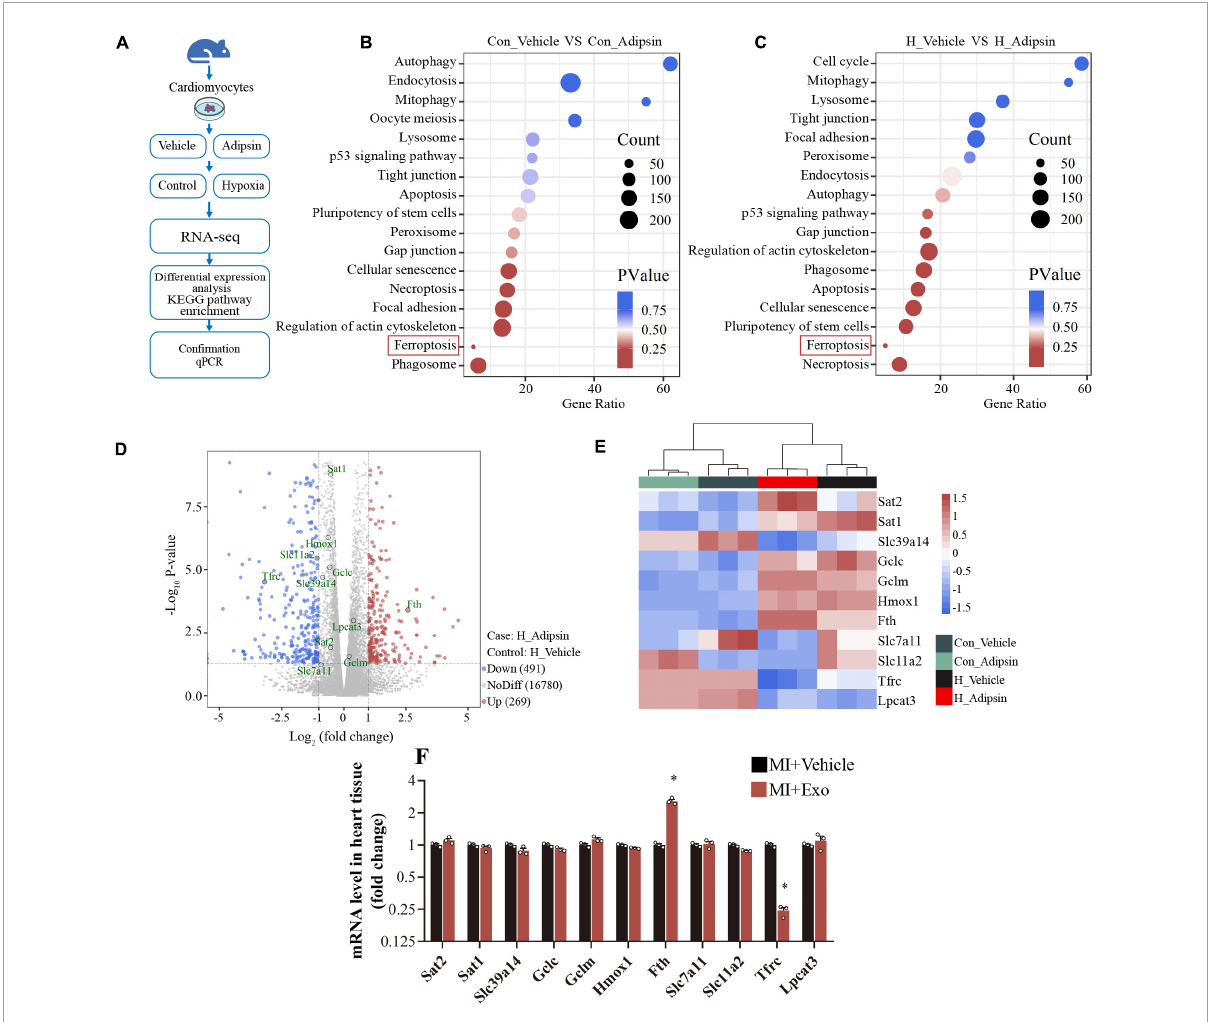
FIGURE4 Adipsin regulates ferroptosis pathway in vitro . (A) Flowchart of the study design. Neonatal mouse ventricular cardiomyocytes were treated with recombinant Adipsin protein. Following that, cardiomyocytes were exposed to hypoxia for 6–8 h. Next, RNA sequencing was performed on the cell genome. (B,C) Pathway enrichment investigation. (D) Under hypoxia, the Volcano graph shows differentially expressed genes. (E) The Heatmap of differentially expressed genes about ferroptosis. (F) Using quantitative PCR, the expression profile of ferroptosis-related genes in cardiac tissue post MI was investigated after Adipsin-enriched pericardial-AT exosomes treatment. n = 3, * p < 0.05 vs. MI + Vehicle group. Data were mean ± SEM, and one-way ANOVA was used for statistical